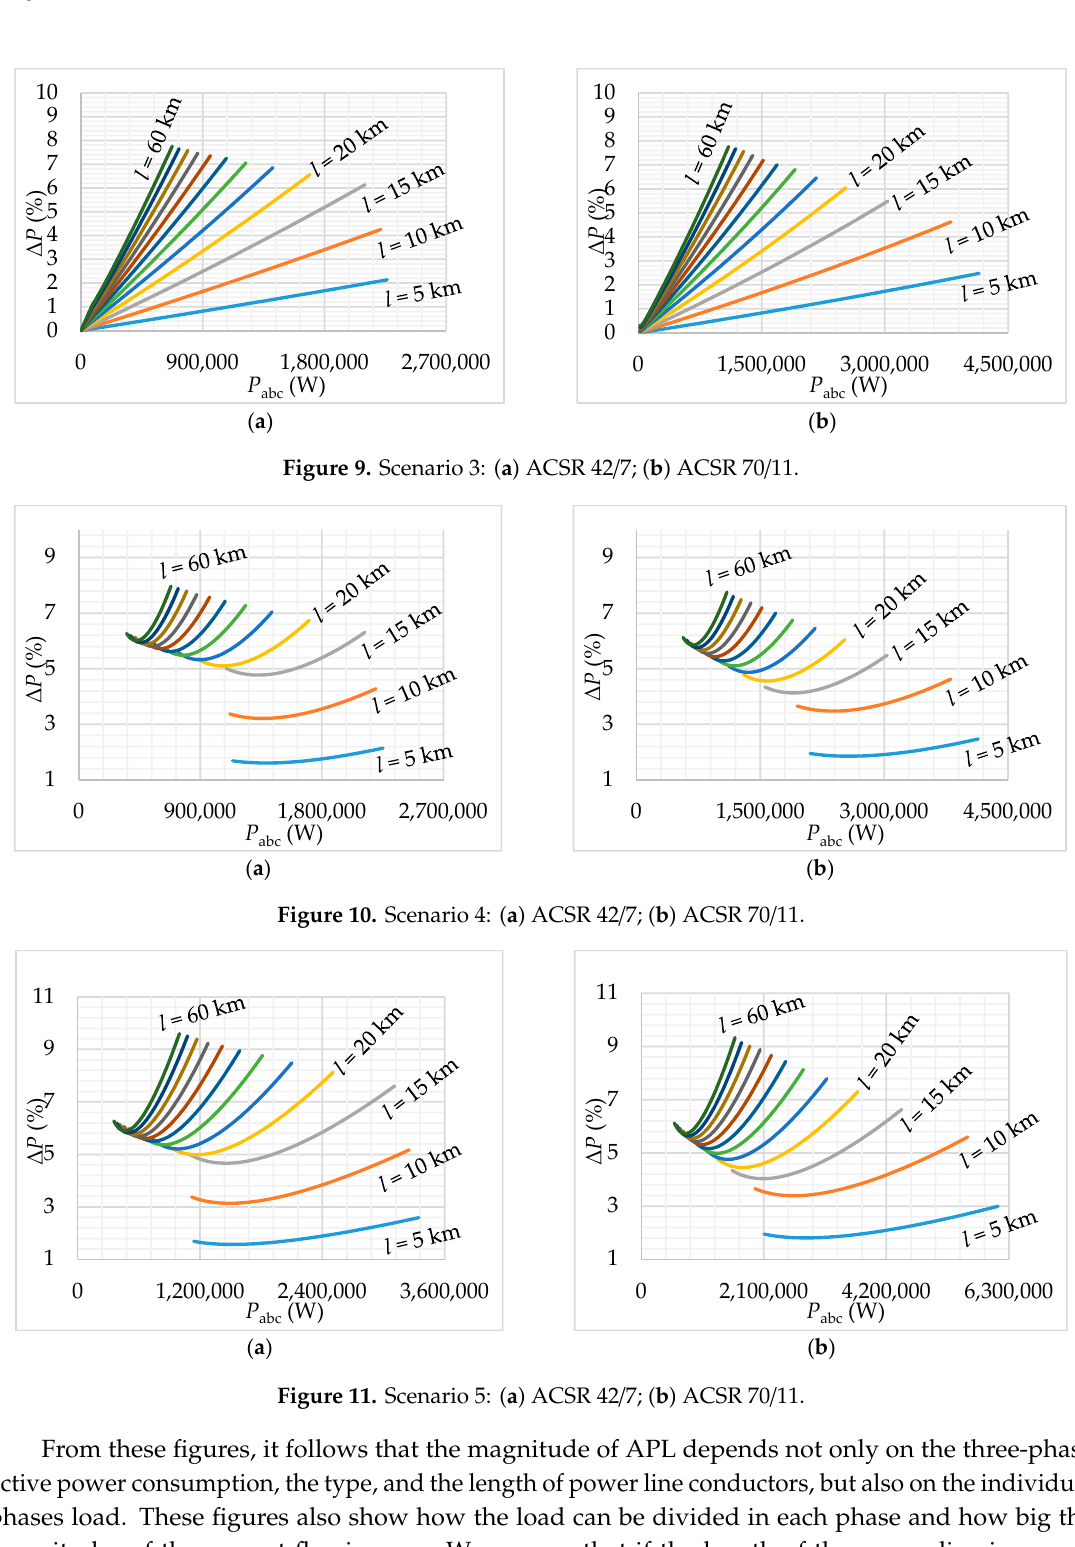
Figure 12. The dependence of increasing APLs from three-phase active power consumption for ACSR 42/7: ( a ) the length of 5 km; ( b ) the length of 30 km.